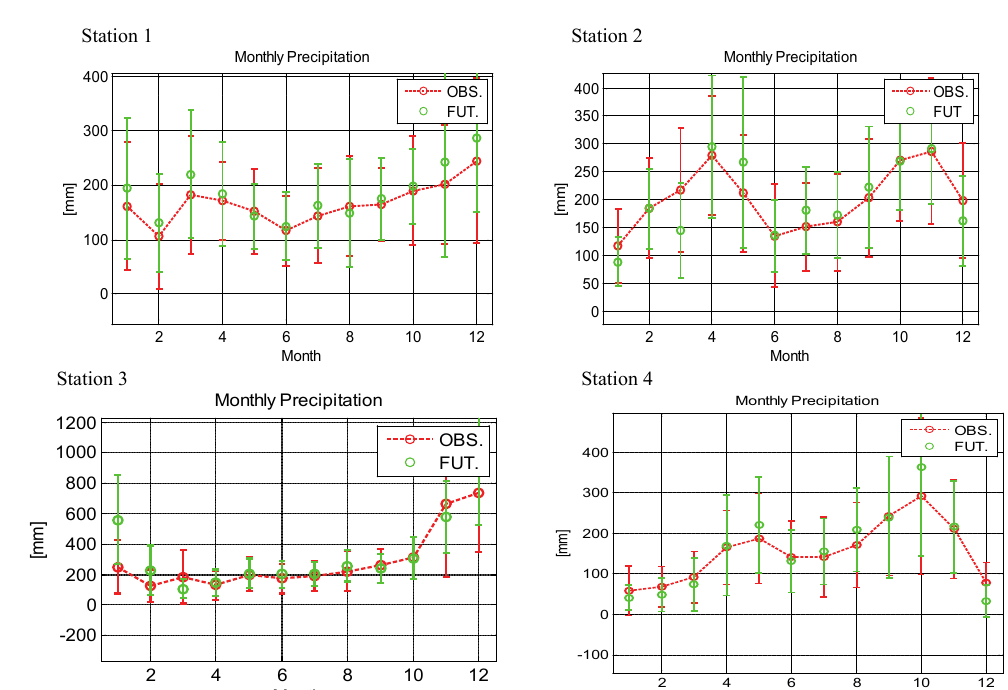
Fig. 4 A comparison between observed (‘--o’) and future (‘o’) monthly precipitation. The vertical bars denote the standard deviations of the monthly